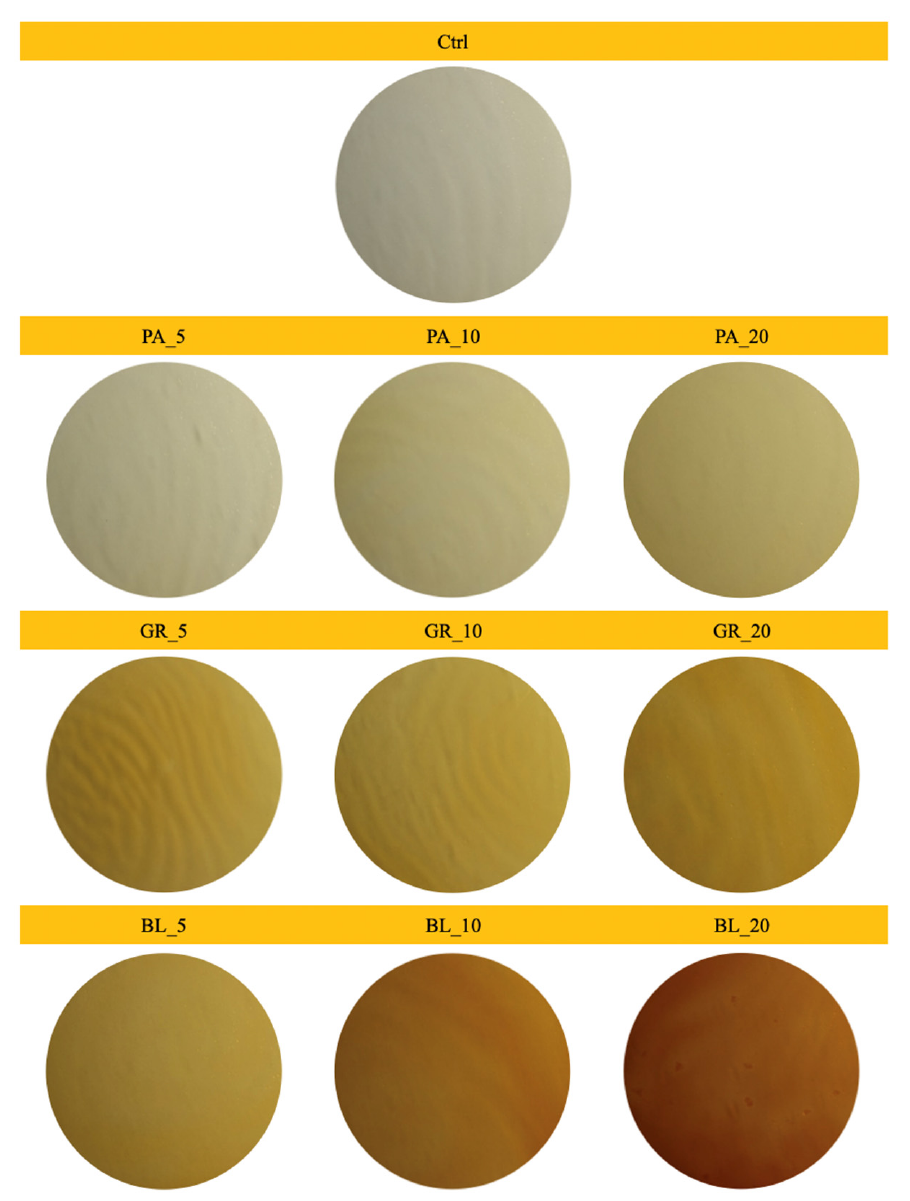
Figure 3. Digital images of edible coatings used for colour analysis (BL_5, edible coating with 5% of blueberry extract; BL_10, edible coating with 10% of blueberry extract; BL_20, edible coating with 20% of blueberry extract; GR_5, edible coating with 5% of red grape extract; GR_10, edible coating with 10% of red grape extract; GR_20, edible coating with 20% of red grape extract; PA_5, edible coating with 5% of parsley extract; PA_10, edible coating with 10% of parsley extract; PA_20, edible coating with 20% of parsley extract; Ctrl, control = edible coating without added extract). Table 6. Parameters of edible coating colour.